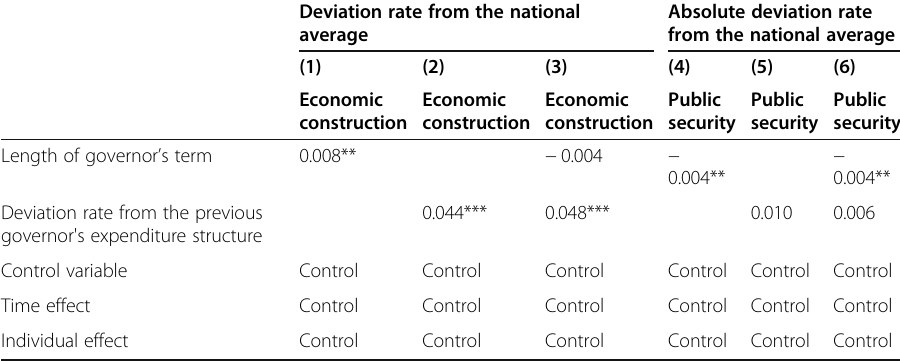
Table 4 The relationship between the fiscal expenditure structure and the governor ’ s “ goal ” Deviation rate from the national